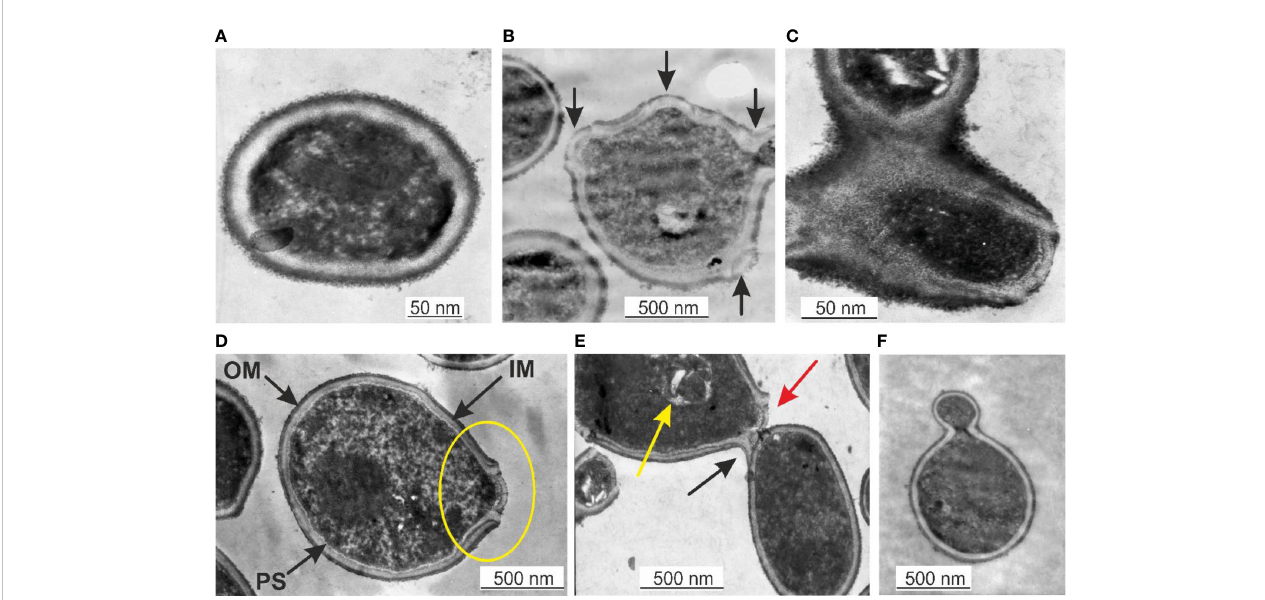
FIGURE 1 (A) Primary cell with a mossy cell wall. Bar 50 nm. (B) Cell surface protrusions where new progeny cells erupt (black arrows). (C) Junction of progeny cells (septum). (D) Ultrastructures of blood microbiota. Black arrows indicate the inner membrane (IM), intermediate translucent periplasmic space (PS), outer membrane (OM), and progeny extrusion site (yellow ring). (E) A progeny cell is attached to the “ mother ” cell (black arrow), a progeny cell prepared for extrusion (red arrow), and a progeny cell inside the “ mother ” cell (yellow arrow). (F) Classical